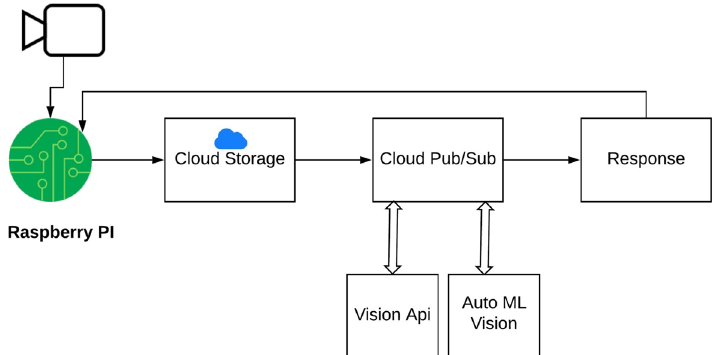
Fig. 10 Flow of working of object detection